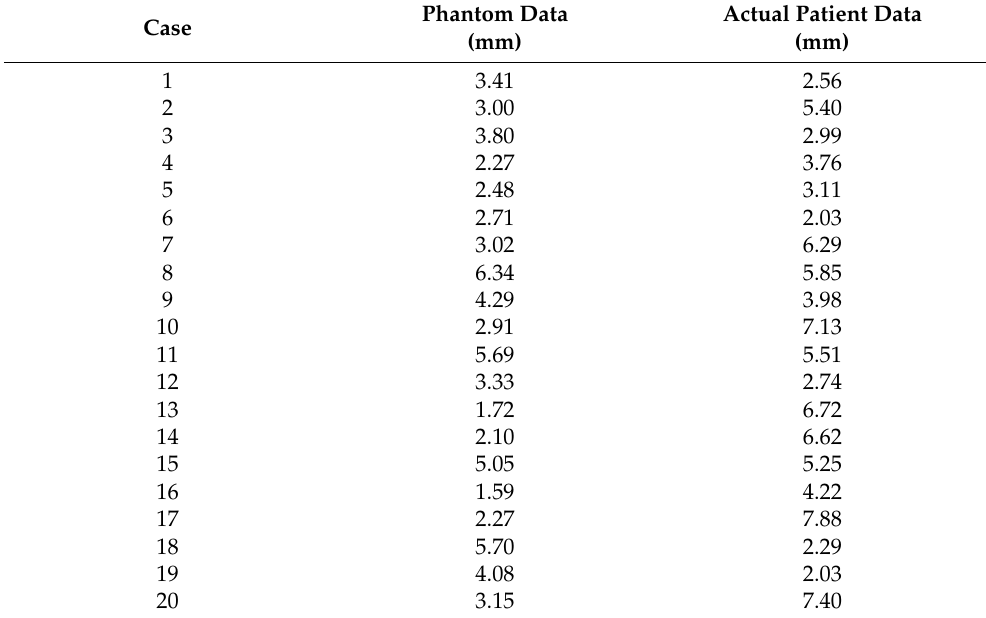
Table 2. Registration error with phantom and actual patient